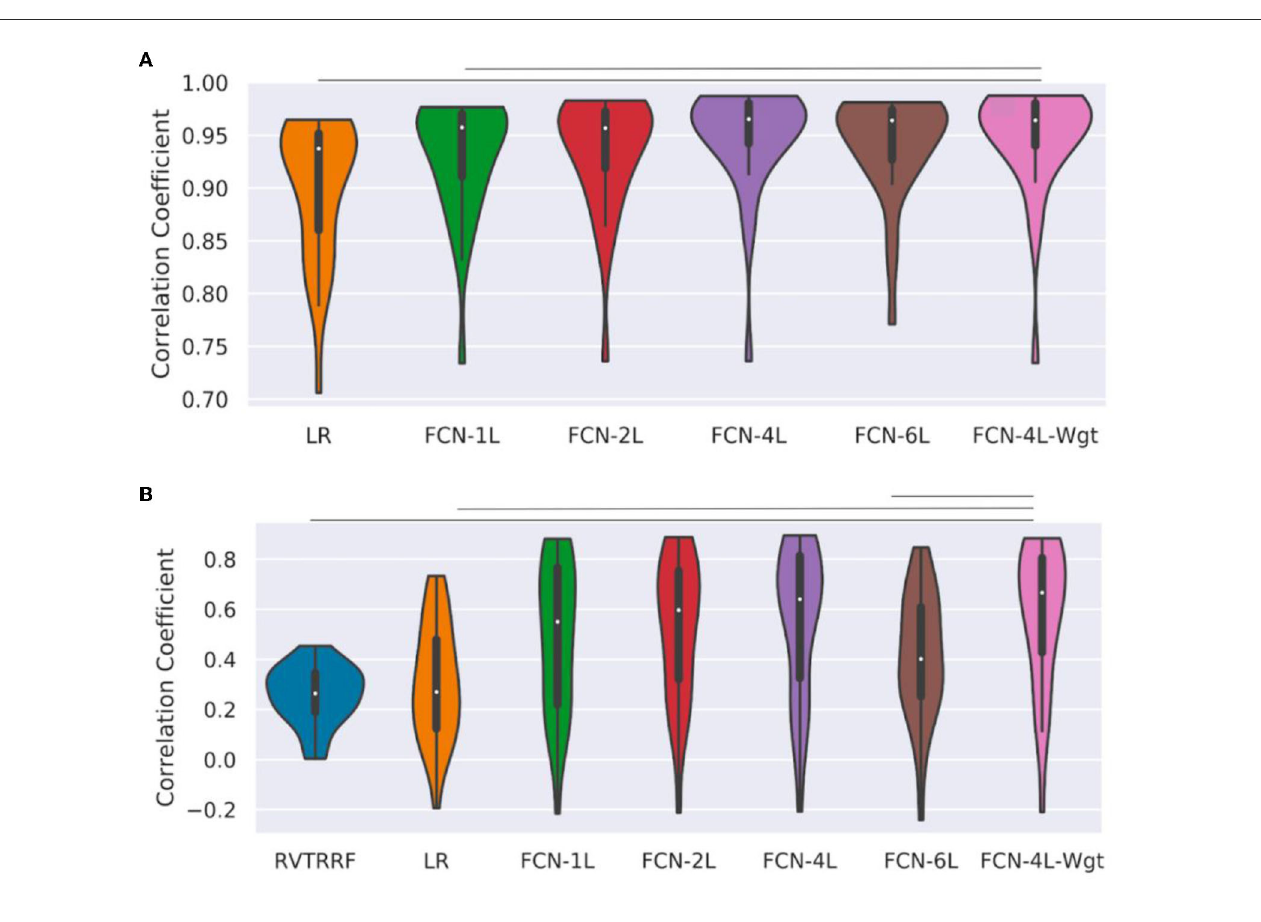
FIGURE5 Performance of different methods: Distribution of correlation coefficients (r) on test dataset, where r is computed between (A) ground-truth and predicted CO 2 , and (B) the ground-truth and predicted PETCO 2 obtained on the test dataset (for one of the five splits) is compared for different models used in the study and shown in the form of a bean plot. The median r for each method is shown as a white dot at the centers of the distributions. The horizontal lines indicate statistically significant differences between the two approaches at the ends of the lines. The FCN-4L-Wgt approach is significantly superior than the RVTRRF and LRF approaches for predicting CO 2 , and better than FCN-6L additionally in predicting PETCO 2 , shown by the significantly higher r